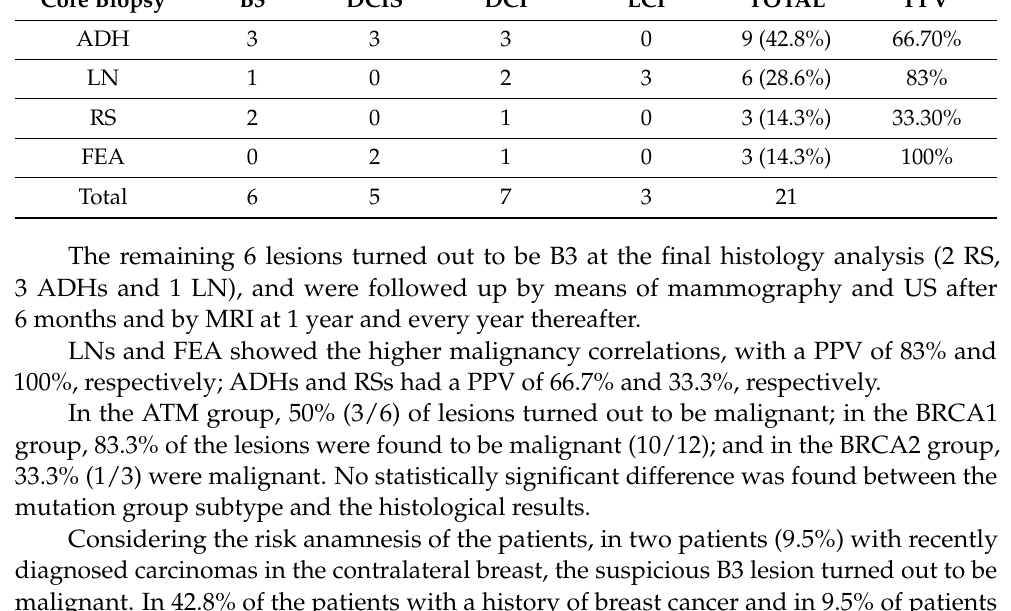
Table 1. Outcome stratified into the different histologic entities classified as B3. Core Biopsy